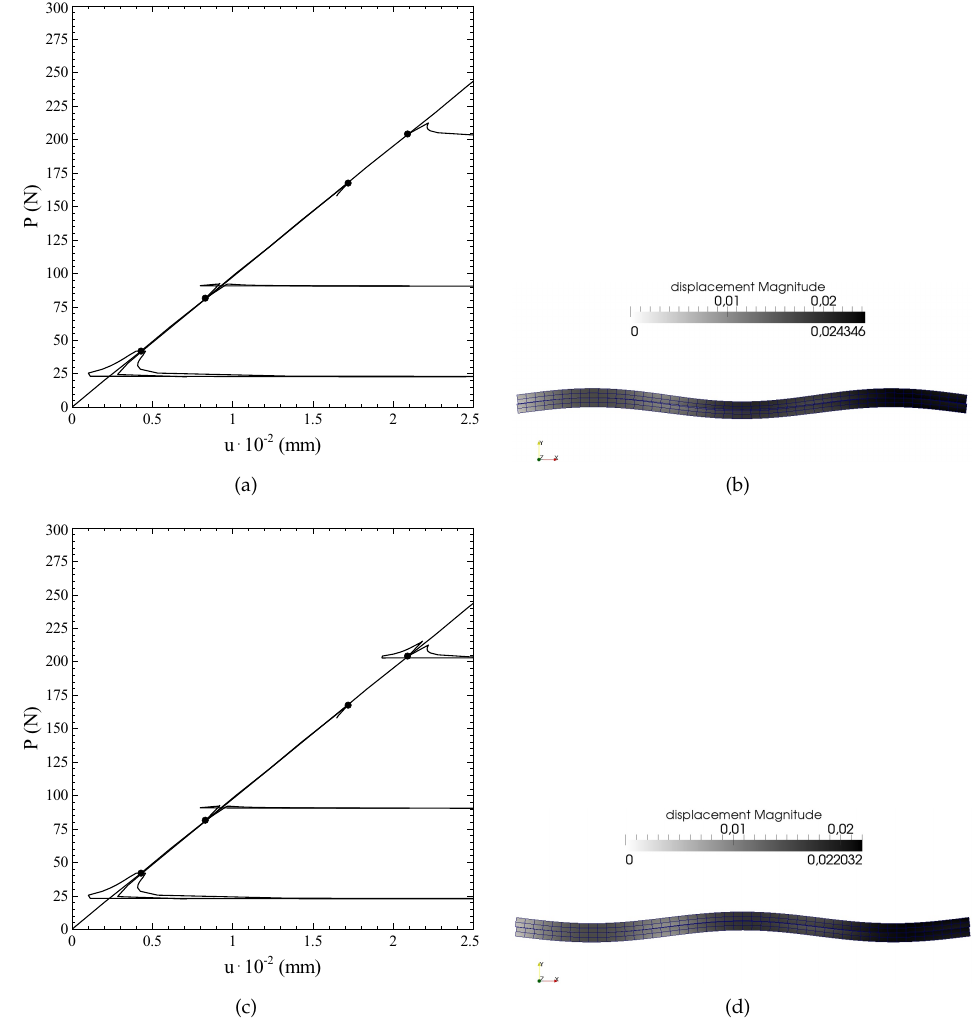
Figure 9. Computation of the fourth bifurcation branch: ( a ) positive side of the branch, ( b ) corresponding deformed shape, ( c ) negative side of the branch, ( d ) corresponding deformed